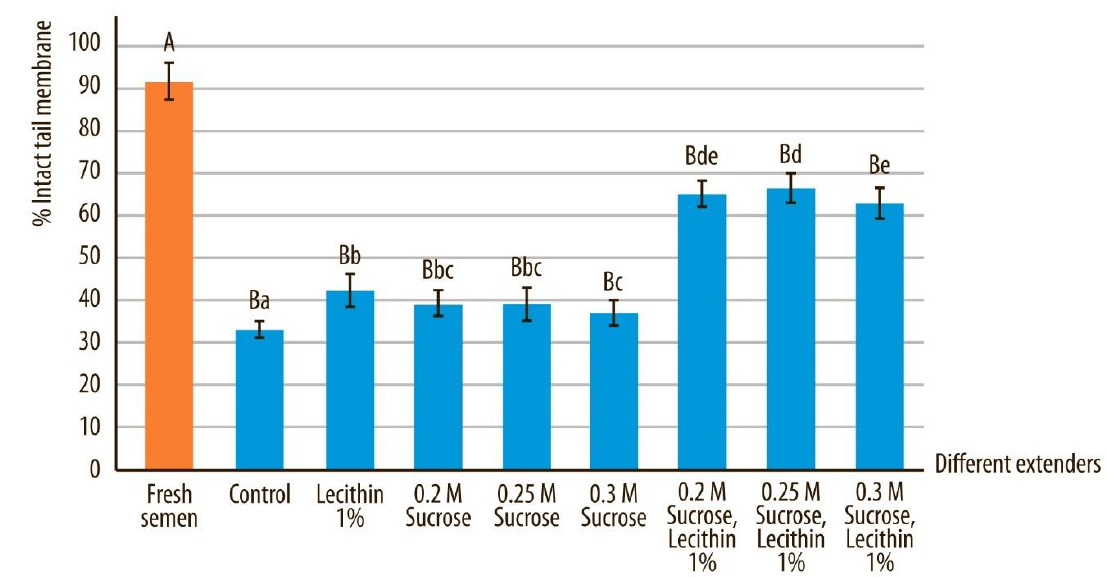
Figure 7. Sperm tail membrane integrity in canine spermatozoa after devitrification regarding different vitrification media. Data are expressed as mean ± SD.